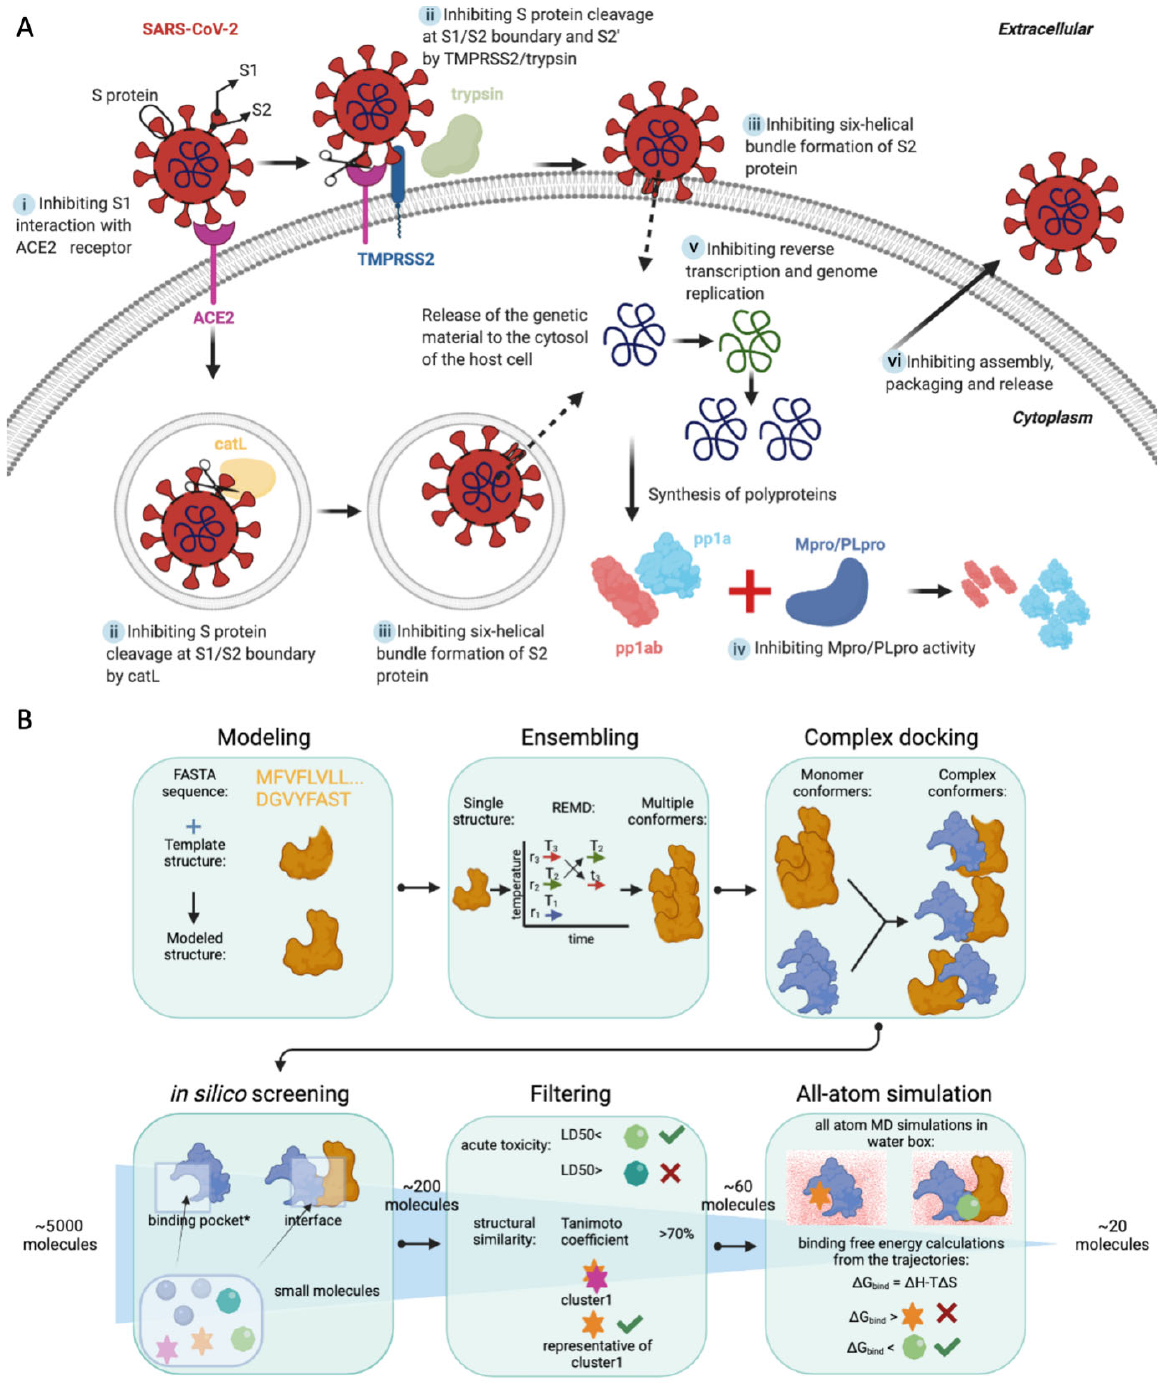
Figure 1. The targeting strategy and pipeline. ( A ) A summary of viral protein targeting strategies. Among six main strategies denoted here as i, ii, iii, iv, v and vi, we focused on ii. ( B ) The computational pipeline flow used for screening drugs starting from the target FASTA sequence to the bench. r in the ensembling panel stands for replica, while T in the same panel stands for temperature. Binding pockets of the monomers correspond with the interface sites of each binding partner in the complex. The number of small molecules at the beginning of the in silico screening and in-between each step is written before and after the steps. In silico screening starts with 5000 molecules; this number decreases to 200 after the screening. Then, filtering narrows this number down to 60 molecules. MD simulations and binding free energy calculations result in 20 molecules to be evaluated on the bench. This figure is created with